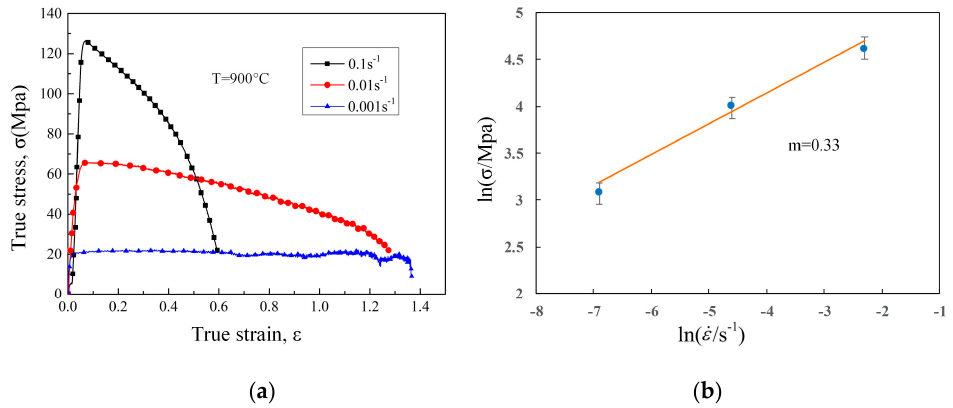
Figure 7. ( a ) The flow curves of TA17 with di ff erent strain rates at 900 ◦ C. ( b ) The m